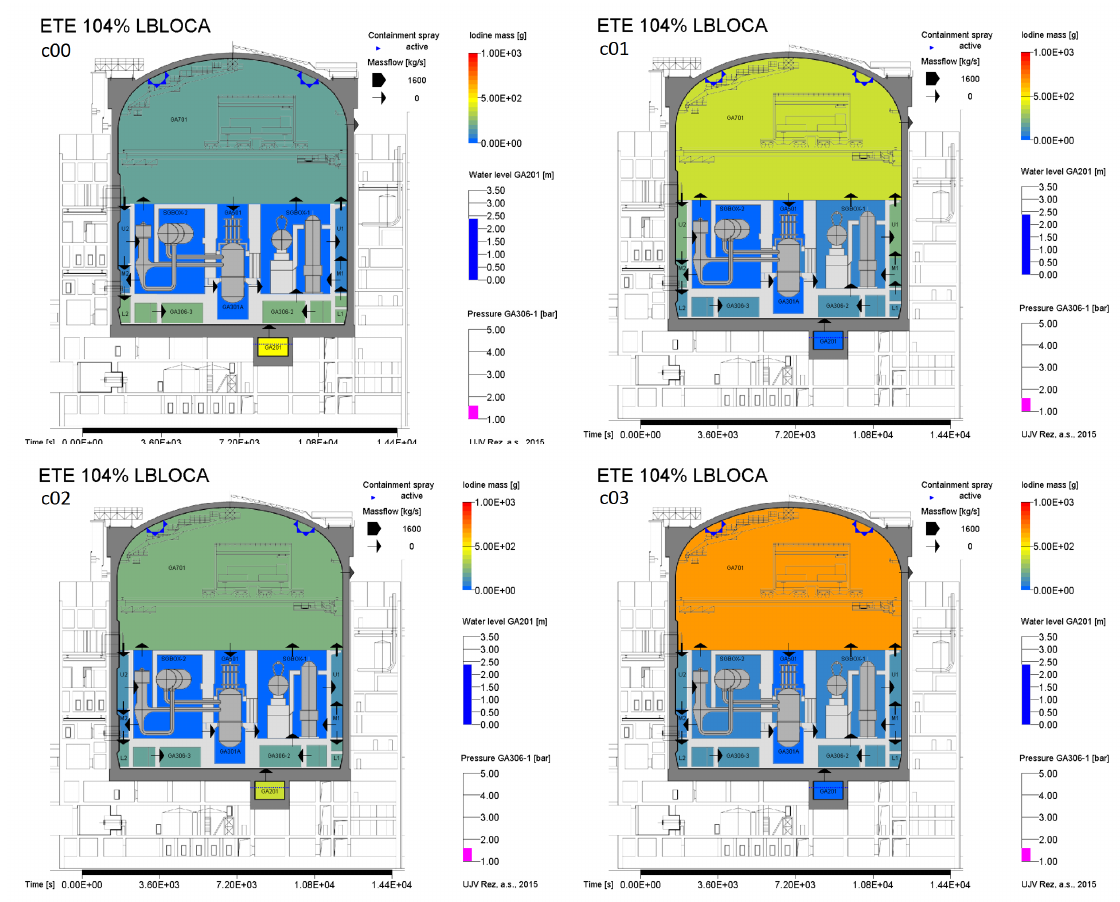
Figure 3. Distribution of iodine in the containment (c00–c03, 14 400